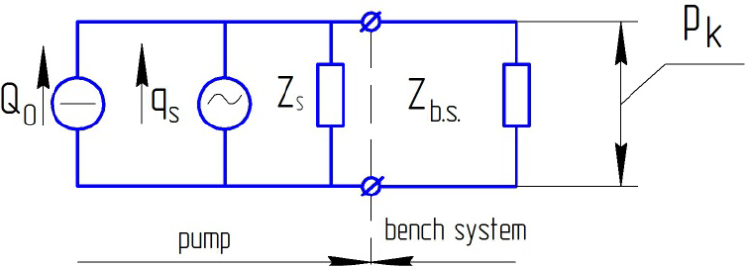
Figure 8. Design diagram of the pump and bench system. p pulsating pressure with the impedance Z b.s.